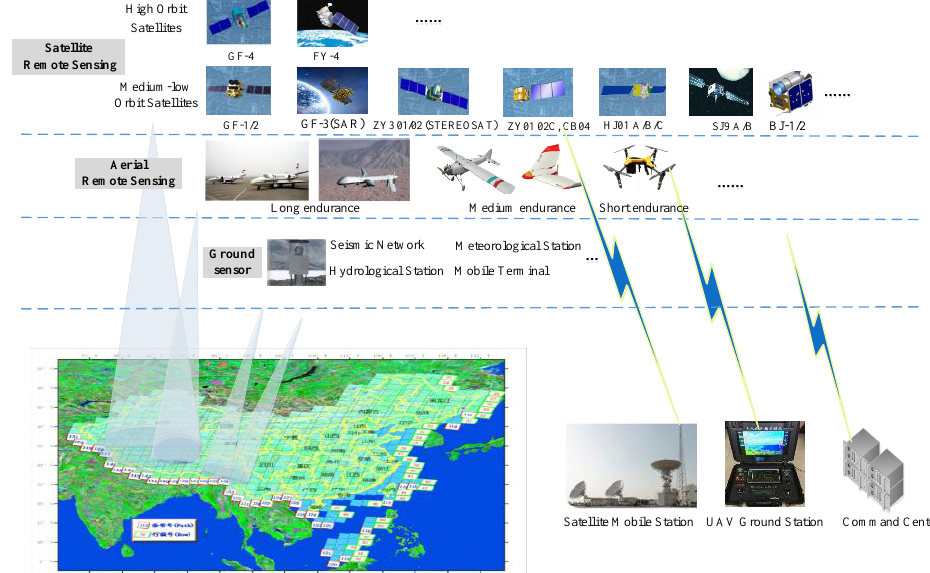
Figure 1. The process of